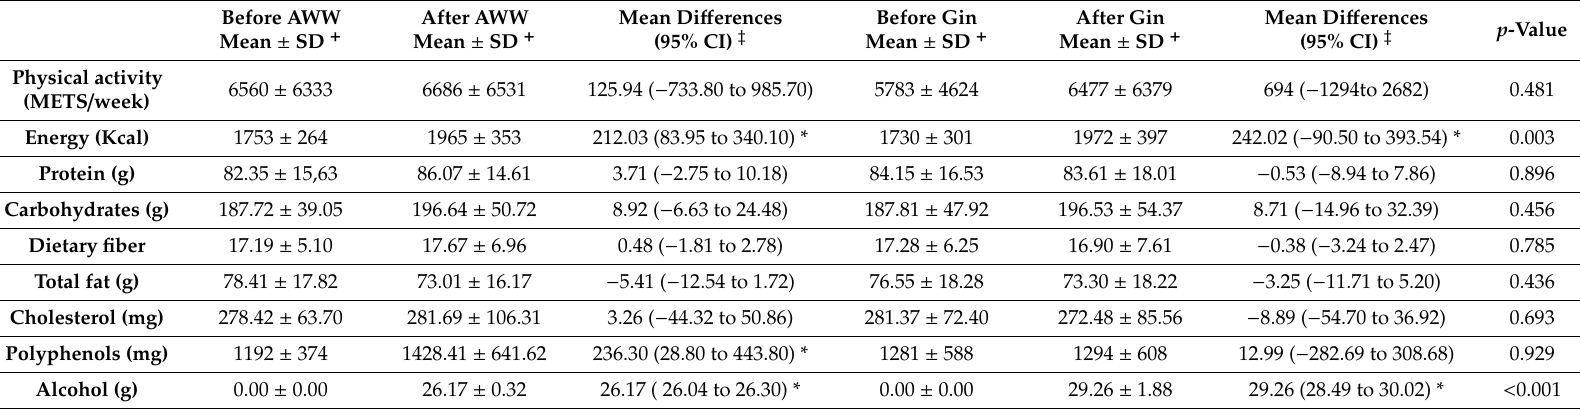
Table 3. Values of the mean nutrients and physical activity before and after the 3-week aged white wine (AWW) and gin